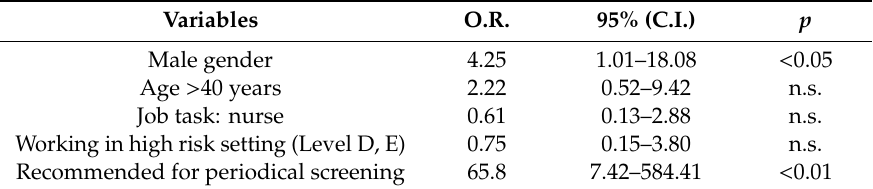
Table 2. Odds ratio (OR) for IGRA conversion in relation to gender, age class, job task, and risk